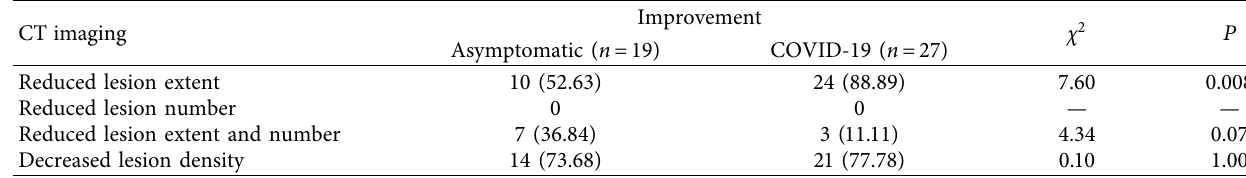
Table 7: Improvement of asymptomatic carriers and COVID-19 patients.